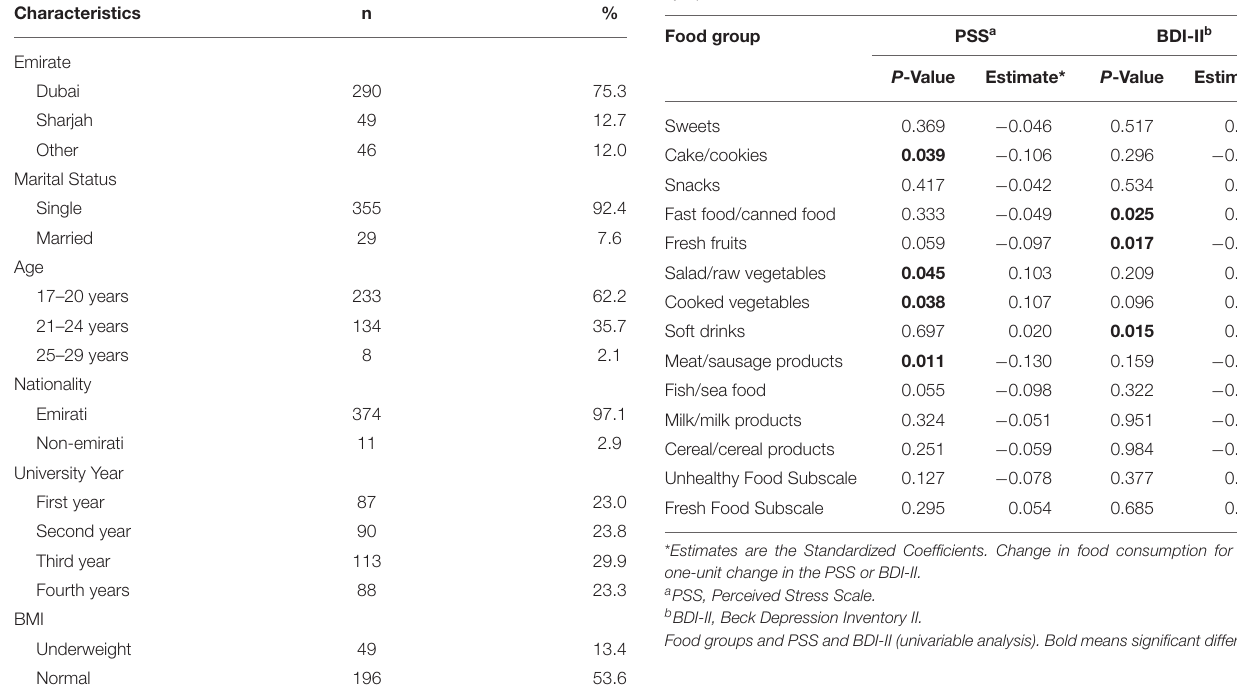
TABLE 2 | Associations between food intake and perceived stress or depressive symptoms. Food